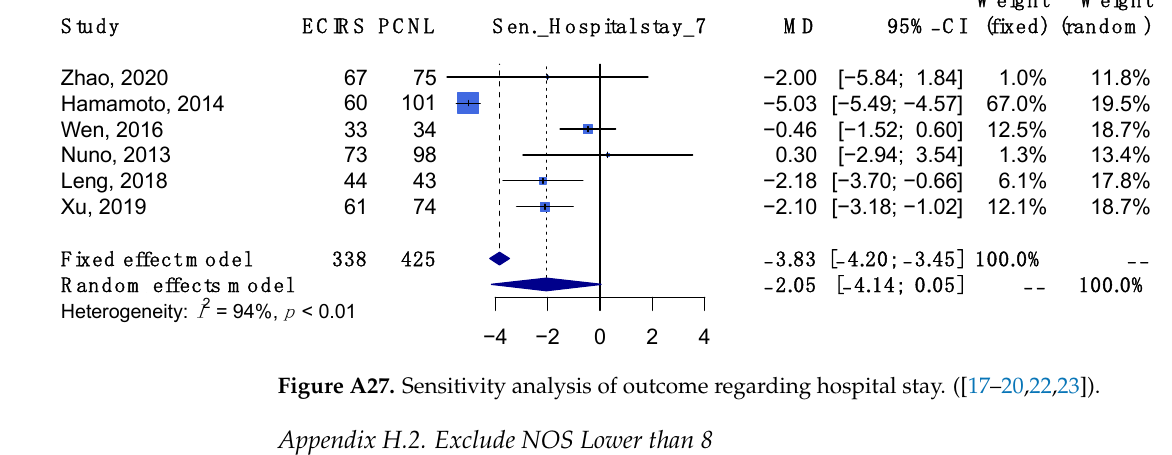
Figure A27. Sensitivity analysis of outcome regarding hospital stay. ([17–20,22,23])